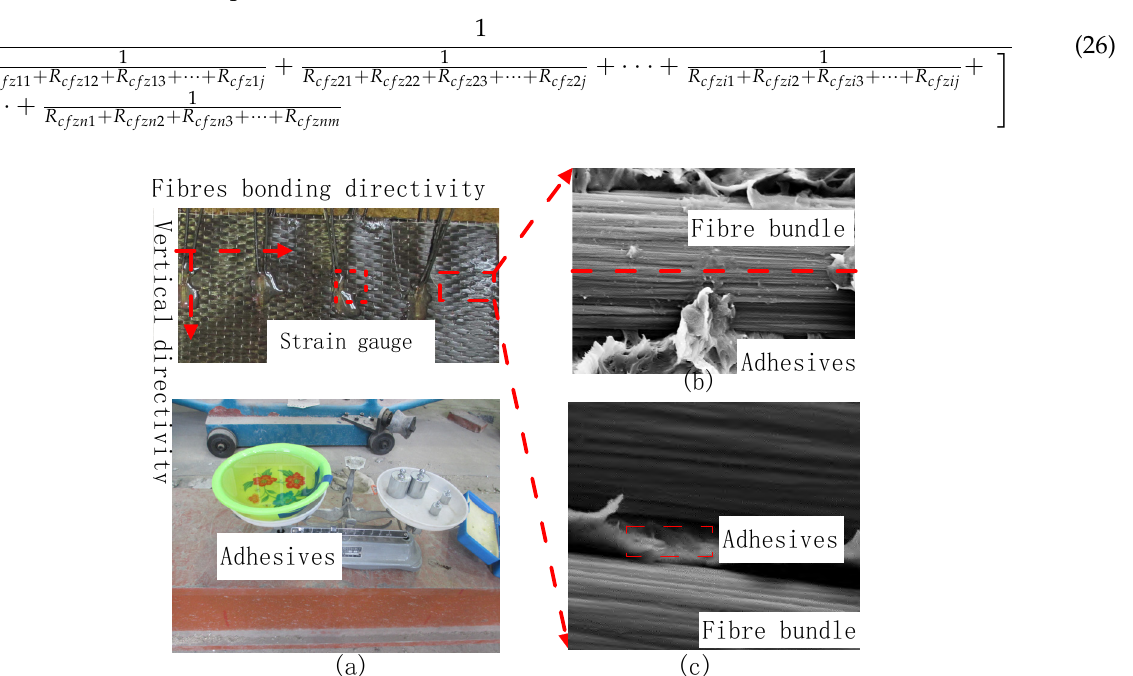
Figure 3. Connection of inner-adhesive-type CFRP: ( a ) operation process of CFRP bonded by adhe- sives; ( b ) fibre connection along the bond length; ( c ) fibre connection along vertical alignment.